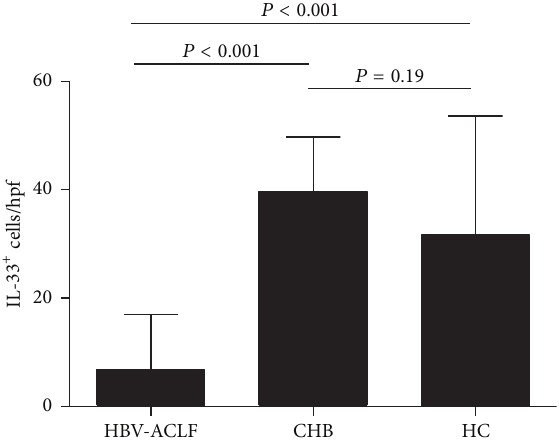
Figure 3: Significantly fewer IL-33 + cells were detected in liver tissues obtained from hepatitis B virus-related acute-on-chronic liver failure (HBV-ACLF) patients compared with those obtained from chronic hepatitis B (CHB) patients and healthy controls (HC). Data shown are the mean number of IL-33 + cells ( ± SD) determined in 10 high-power fields (hpf; 200x). Group differences were analyzed by Mann-Whitney 𝑈 test.